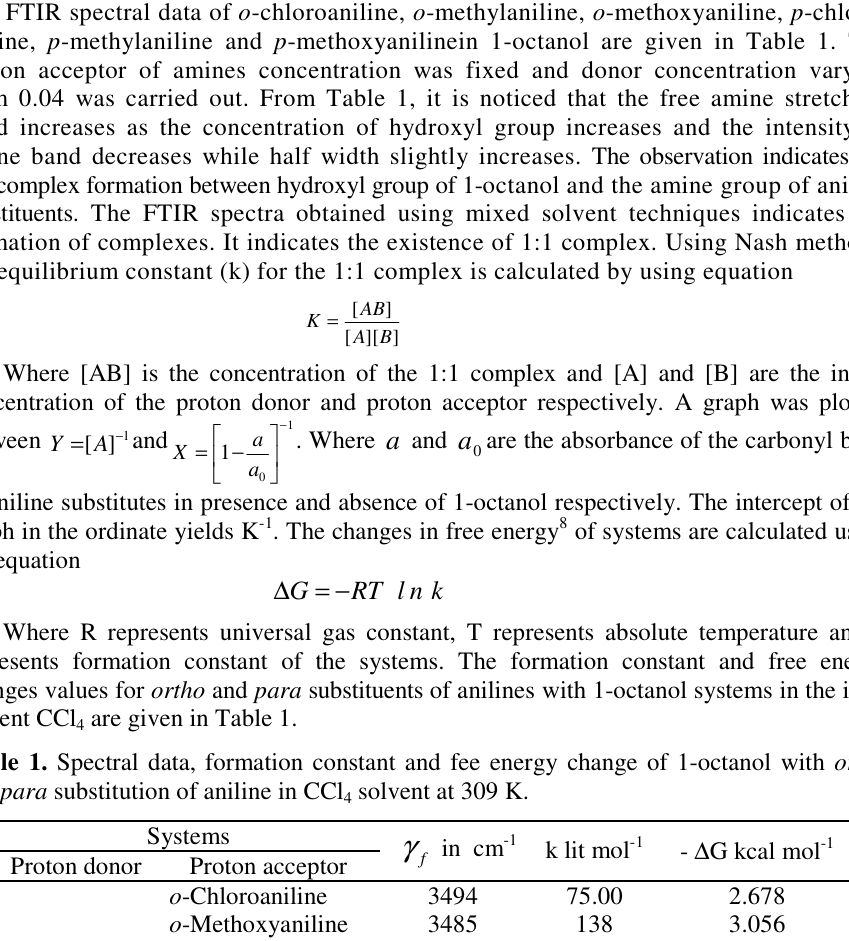
solvent at 309 4